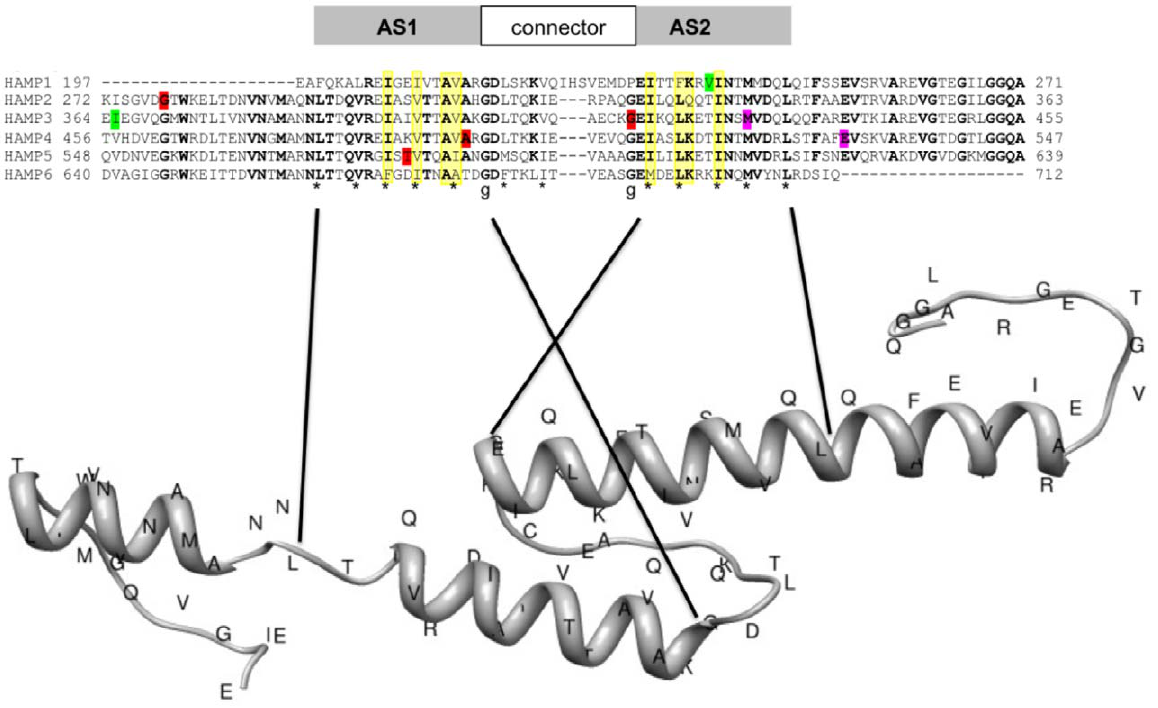
Figure 1. Sequence conservation and model structure of Bos1 HAMP domains. The amino-acid sequences of the six HAMP domains of the Bos1 protein were aligned with Clustal W. Amino acids identical over 80% are in bold. In the bottom panel ‘‘*’’ denotes hydrophobic core residues at critical heptad positions and hydrophobic residues of the connector. ‘‘g’’ corresponds to the conserved glycine residues of the connector motif (according to [35] and [32]). Interacting residues derived from in silico structures are highlighted in yellow. Mutated residues are shaded with the following color code according to the phenotypes indicated in Table 3: red=HR to iprodione and phenylpyrroles, osmosensitivity; green=LR to iprodione; purple=MR to iprodione and osmosensitivity. The structure of the HAMP domain 3 was predicted on the SWISS-MODEL server using the alignment mode (for details see text). Portions of the HAMP sequences involved in the typical HAMP structures AS1, AS2 and the connector are indicated above the sequence. (EC 50 . 4.5 m g ml 2 1 ), but also to phenypyrroles (EC 50 . 8 m g ml 2 1 ) and to iprodione (EC 50 . 25 m g ml 2 1 ), whereas